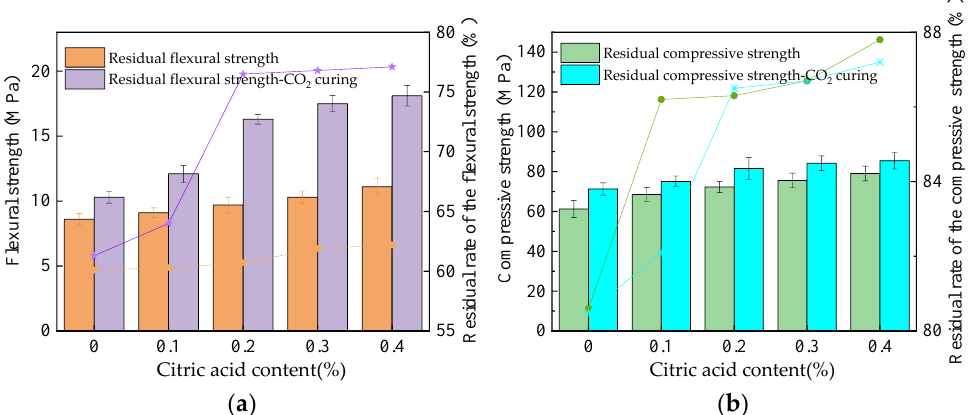
Figure 9. The residual strength of the MOS paste after F-T cycles. ( a ) Flexural strength. ( b ) Compres- sive strength.